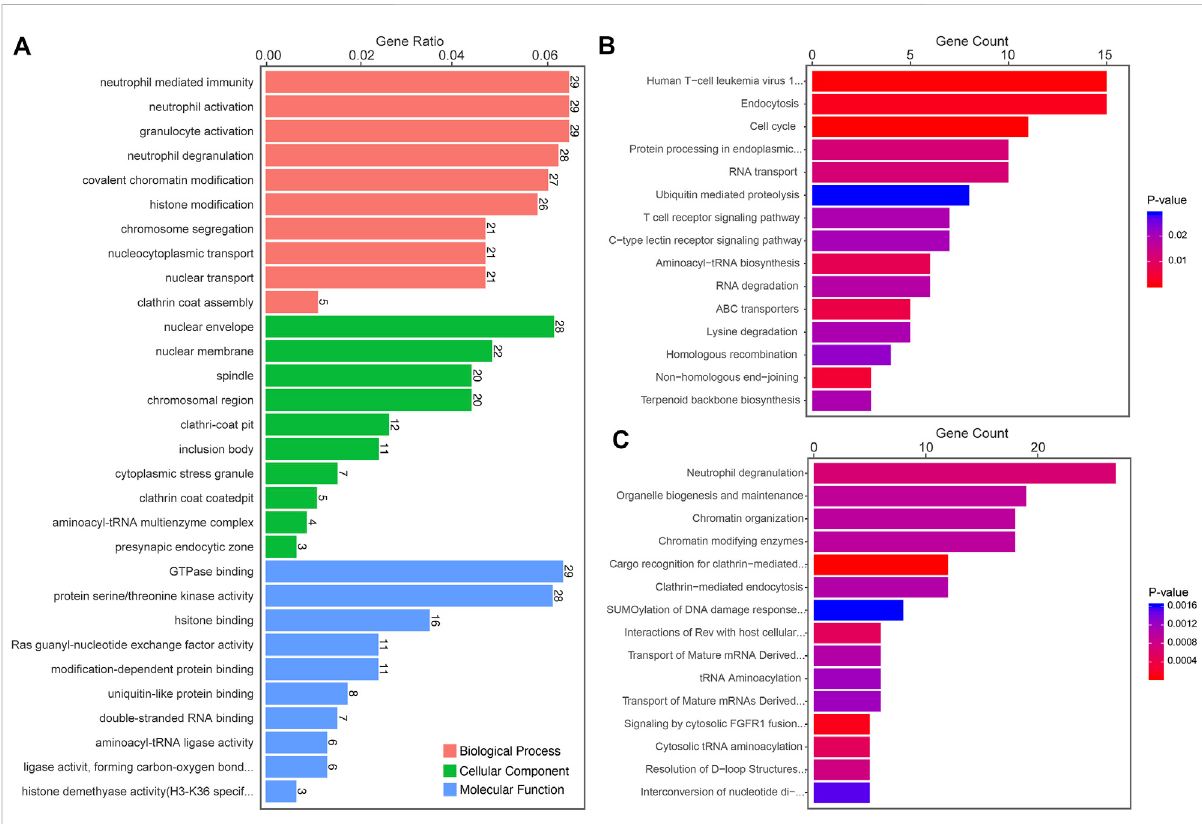
FIGURE 5 Functional predictions of differentially expressed circRNAs between LUAD and healthy individuals. (A) Top 10 GO analysis to demonstrate the molecular functions of dysregulated circRNAs. (B) Top 15 signi fi cant enrichment KEGG pathways of dysregulated circRNAs. (C) Top 15 signi fi cant enrichment Reactome pathways of dysregulated circRNAs. LUAD, lung adenocarcinoma; circRNAs, circular RNA.